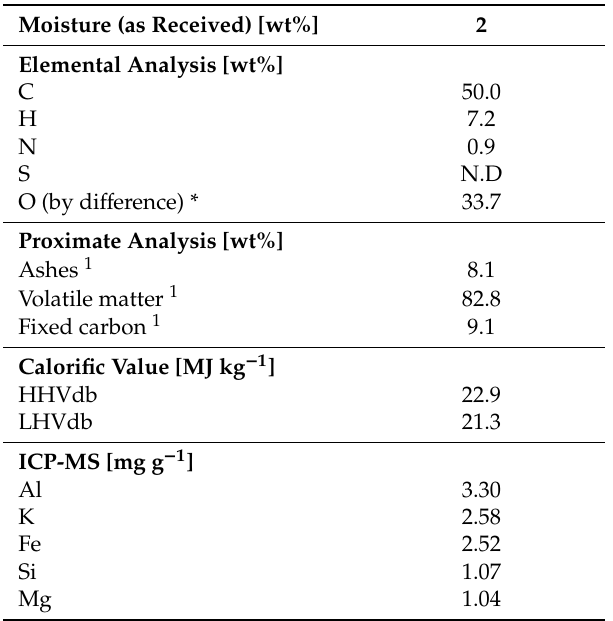
Table 1. Characterization of the sugarcane residual